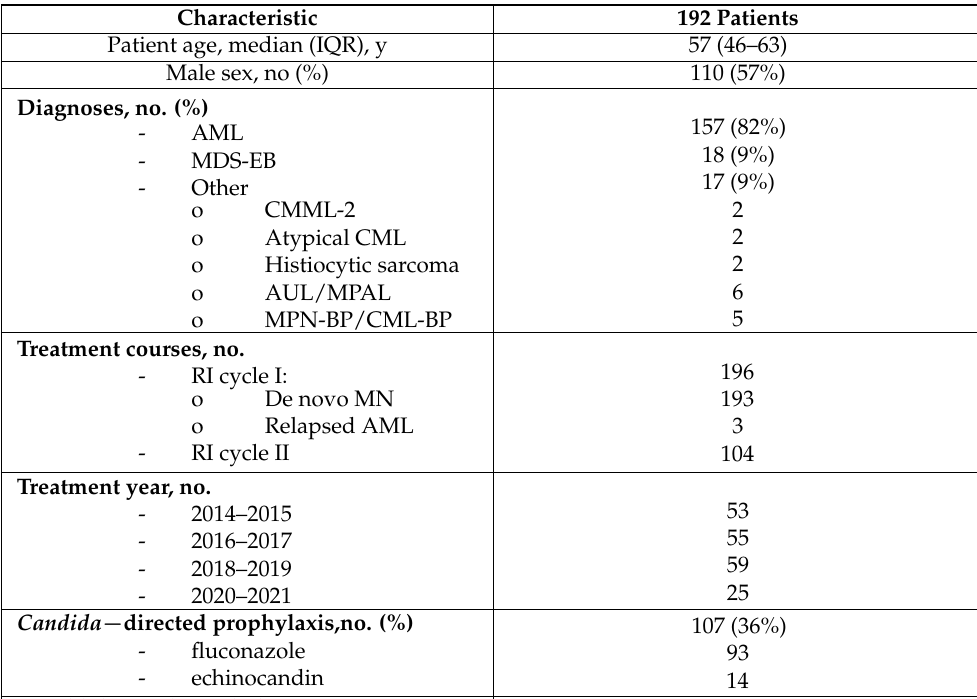
Figure 2. Study inclusion profile. Table 1. Patient and treatment characteristics.